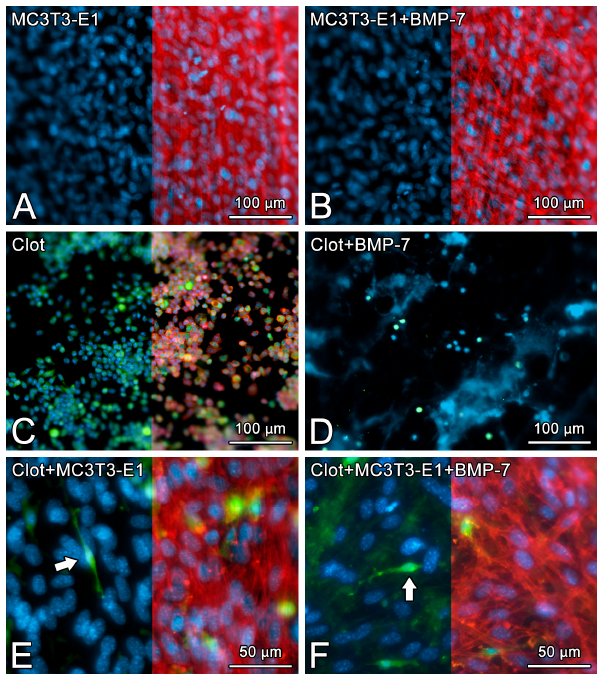
Figure 1. The epifluorescence of MC3T3-E1 cells on day 5 of culture ( A , B ), blood clot alone on time 0 ( C , D ), or the combination of both on day 5 of culture ( E , F ) on pristine Nano-Ti ( A , C , E ) or Nano-Ti functionalized with rmBMP-7 ( B , D , F ). Red fl uorescence (Alexa Fluor 594 phalloidin) indicates the actin cytoskeleton ( A – C , E , F ), green fl uorescence indicates the GFP-positive blood clot leukocytes ( C – F ), and blue fl uorescence indicates the cell nuclei (DAPI nuclear stain) ( A – F ) and the fi brin network ( D ). Red fl uorescence is deleted in the left halves of ( A – C , E , F ) using Adobe Photoshop CS6 for a be tt er visualization of the cell nuclei and GFP-positive cells (white arrows in ( E , F )) in the same microscopic fi eld. Objectives: 20× ( A – D ); 40× ( E – F ).